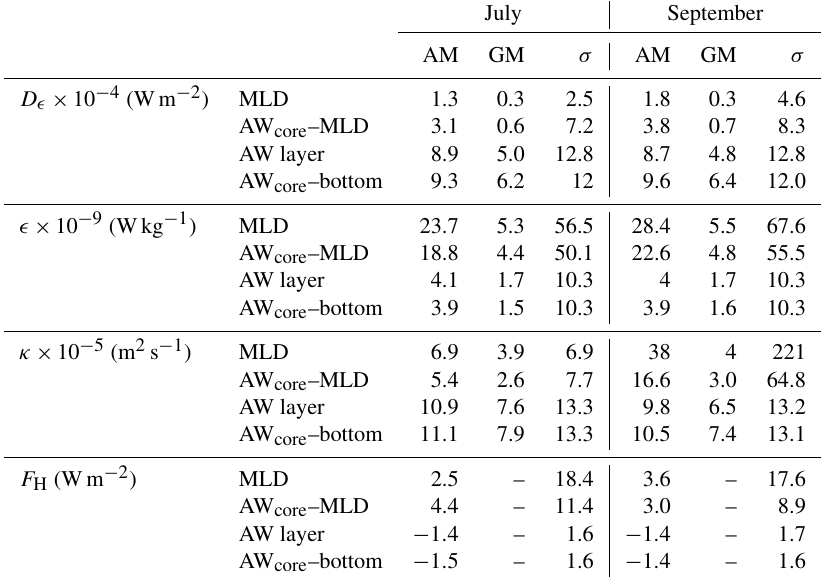
Table 2. Statistics of the turbulence variables measured in July and September. AM: arithmetic mean; GM: geometric mean; σ : standard deviation; D (cid:15) : vertically integrated dissipation rate; (cid:15) : dissipation rate; κ : diffusivity; F H : vertical turbulent heat flux (positive upward). Four layers are defined. MLD: ± 10m around the base of the mixed layer; AW core –MLD: from the Atlantic Water core to the mixed layer depth; AW layer: in the Atlantic Water layer; and AW core –bottom: from the Atlantic Water core to the seafloor. The geometric mean is ill-defined for negative values and hence not provided for the turbulent heat fluxes.